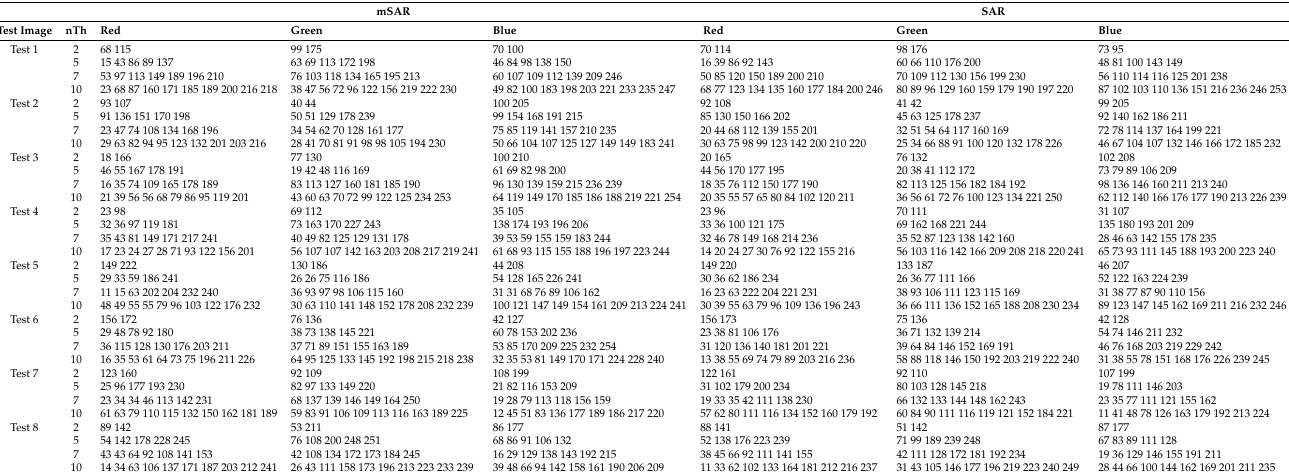
Table A1. The optimal threshold values are obtained by the Fuzzy Entropy method.